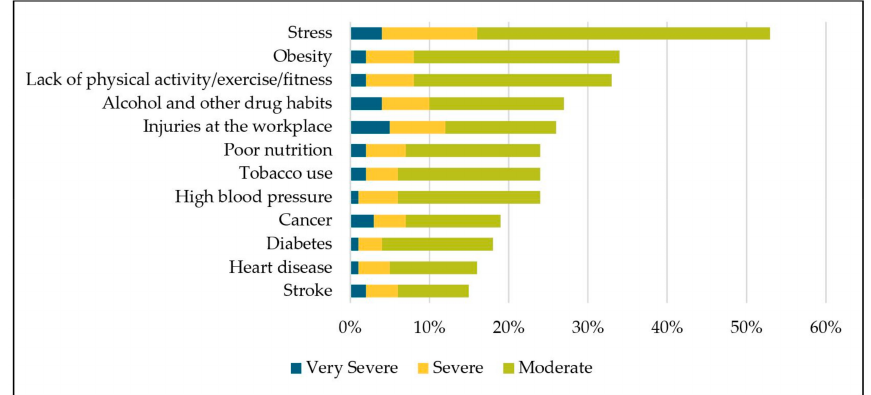
Figure 1. Percentage of Nebraska worksites that reported selected employee health issues negatively impacted business, 2016.